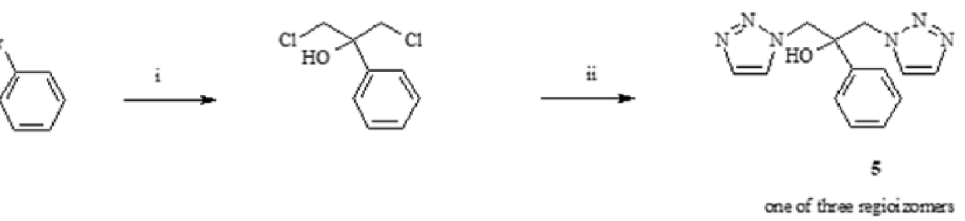
Figure 5. Scheme of synthesis of 1,3-di(1H-1,2,3-triazol-1-yl)-2-(phenyl) propan-2-ol ( 5 ). i—Et 2 O, Mg, 1,3-dichloroacetone; ii—acetonitrile, sodium 1,2,3-trazole, reflux.